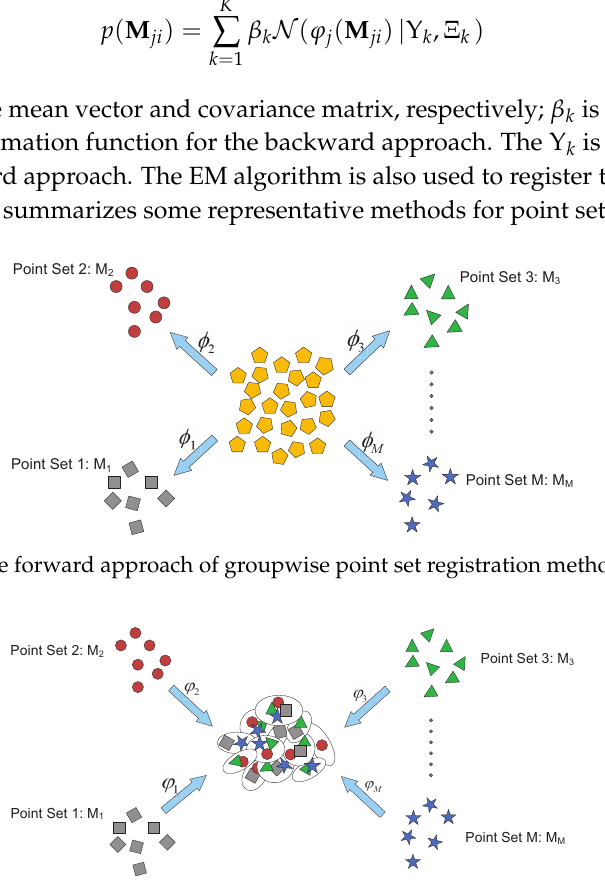
Figure 6. The backward approach of groupwise point set registration method in